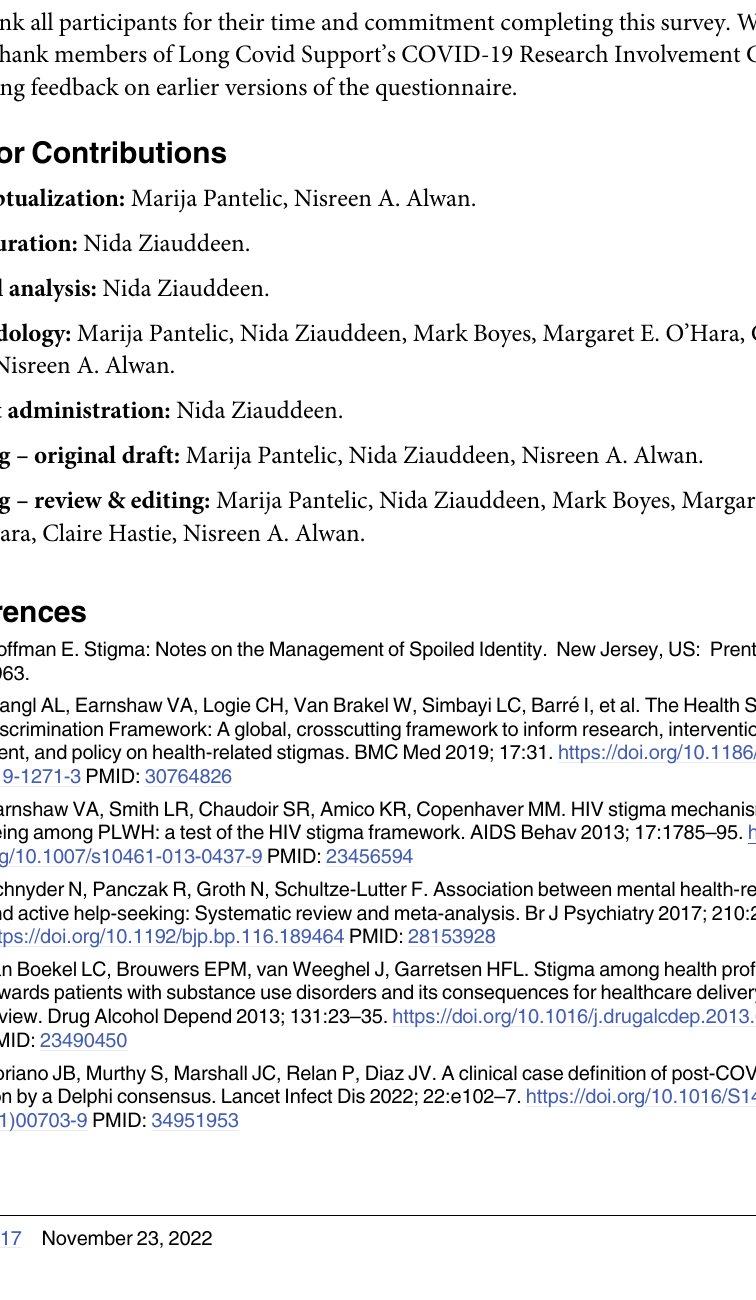
S2 Table. Response option frequencies for each stigma item. S3 Table. Factor loadings of individual stigma items on subscales of internalised, enacted and anticipated stigma using confirmatory factor analysis. S4 Table. Correlations between stigma scores, eight-item Patient Health Questionnaire (PHQ-8 score) and disclosure concerns. S5 Table. Prevalence of reported